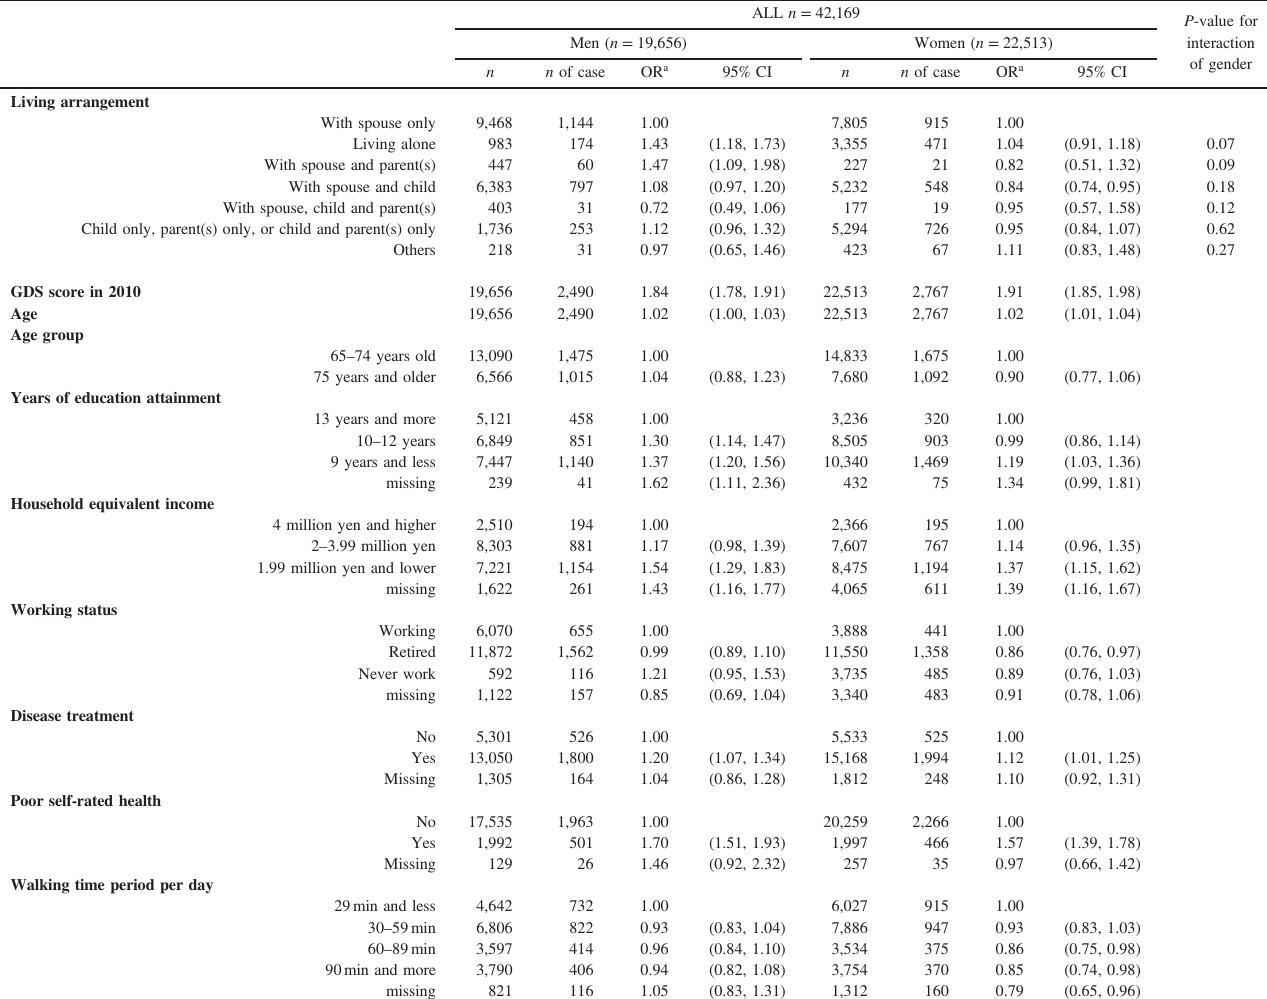
ALL n = 42,169 P -value for genderMen ( n = 19,656) Women ( n = 22,513)